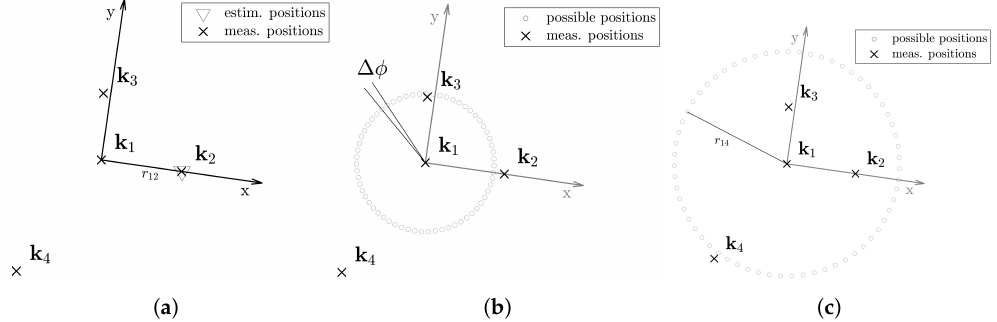
Figure 6. Reduced possible spaces for four anchors. In ( a ) we establish a new coordinate system. The pivotal anchor k 1 is fixed at the origin in x and y . The estimation of the anchor k 2 is fixed at x = r 12 , y = 0. The possible space of the additional anchors k 3 in ( b ) and k 4 in ( c ) are on circles around the